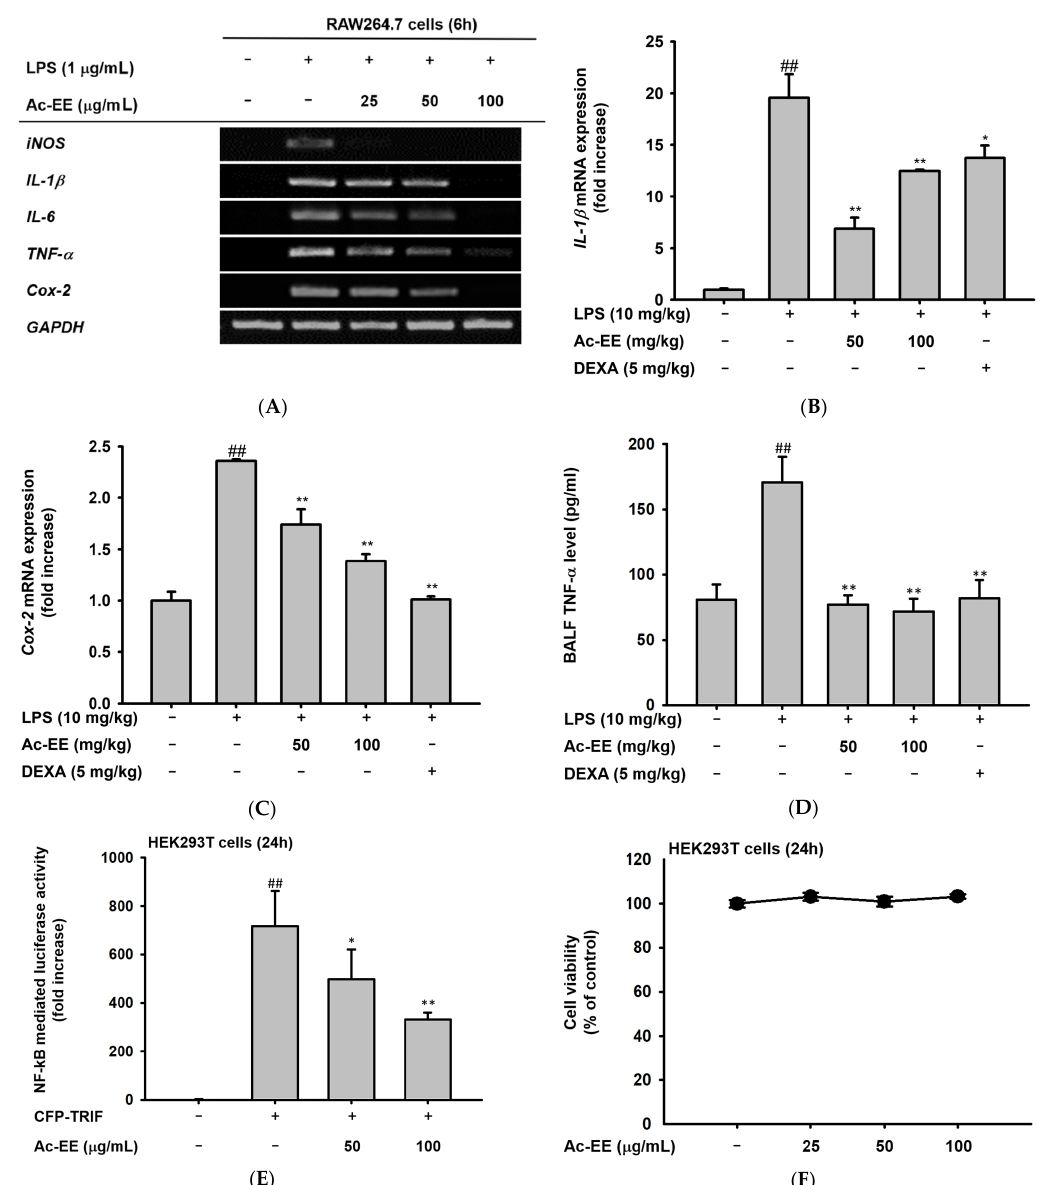
were attenuated by Ac-EE treatment.